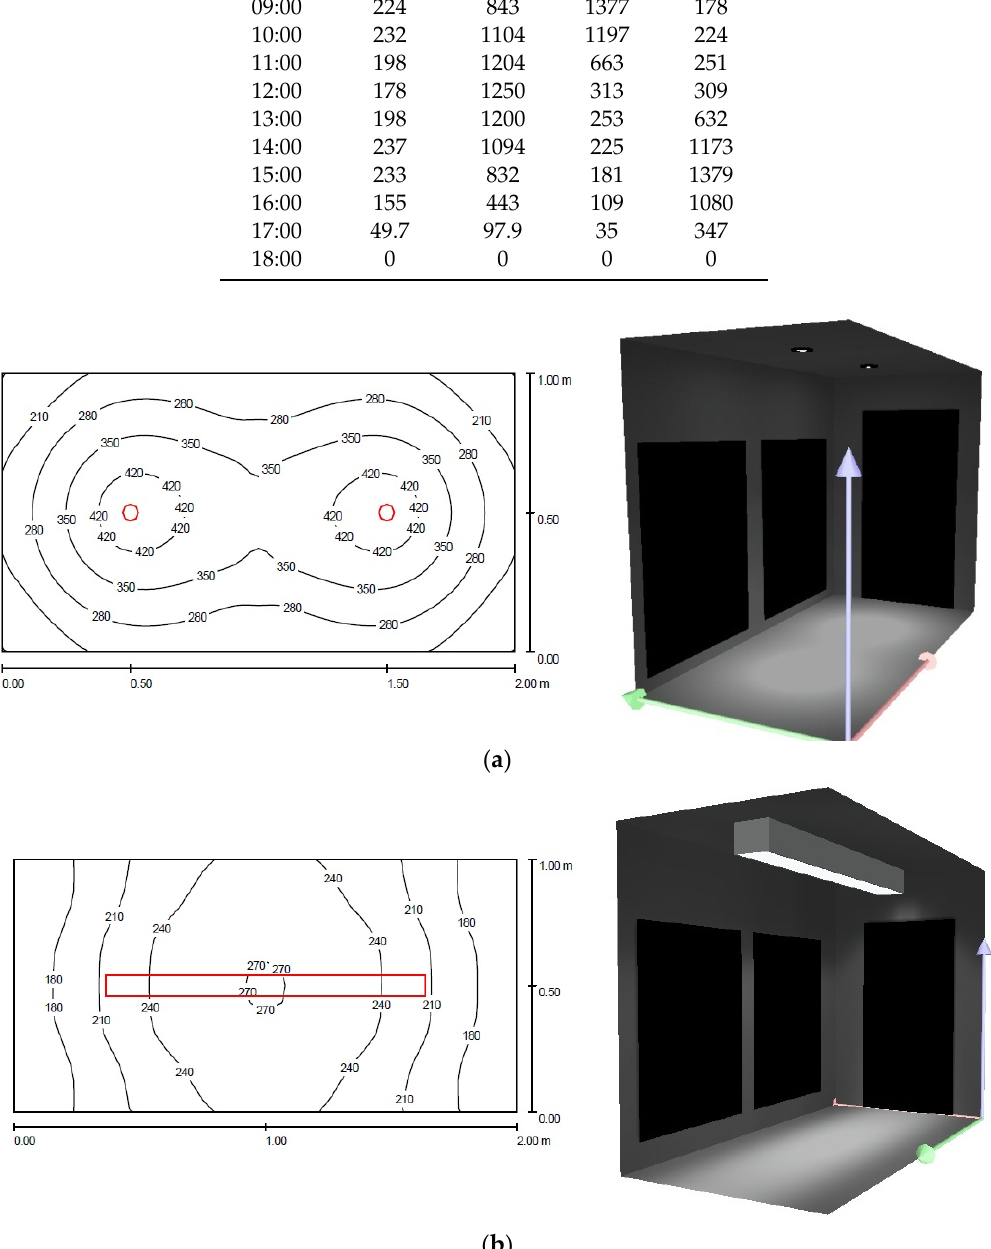
Figure 3. Light distribution profile of the test setup modelled by DIALux software: ( a ) Two sets of 3 × 3 W light emitting diode (LED) luminaire in the test setup; ( b ) Fluorescent T5 luminaire in the test setup.